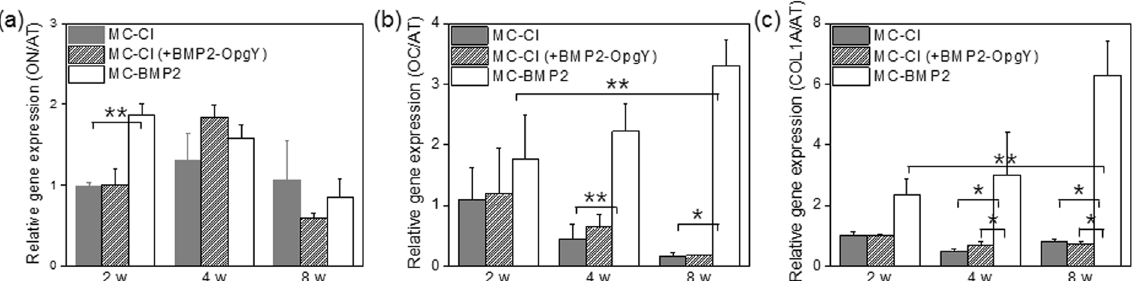
Figure 11. ( a ) Osteonectin (ON), ( b ) osteocalcin (OC), and ( c ) osteopontin (OP) gene expression in human periodontal ligament stem cells on MC-Cl, MC-Cl ( + BMP2-OpgY) and MC-BMP2 hydrogels after 2, 4, or 8 weeks. Results were statistically analyzed using a one-way analysis of variance with Bonferroni’s multiple comparison correction ( * p < 0.01, ** p <